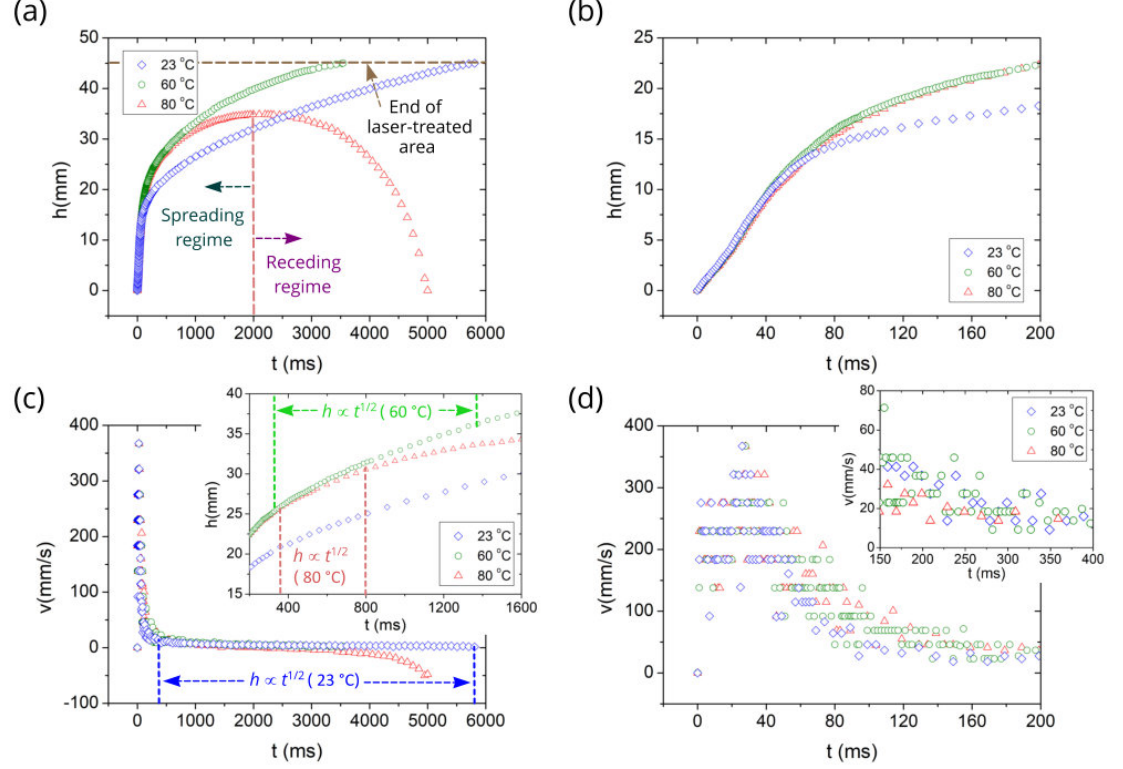
Figure 3. ( a ) Plot of the spreading distance as a function of time at various temperatures. ( b ) Detailed plot of the initial stage taken from ( a ). ( c ) Plot of spreading front velocity as a function of time at various temperatures. The inset shows the Washburn regime timescale at 60 and 80 ◦ C. ( d ) Detailed plot of the velocity in the initial stage. The inset shows the plot of velocity as a function of time between 150 and 400